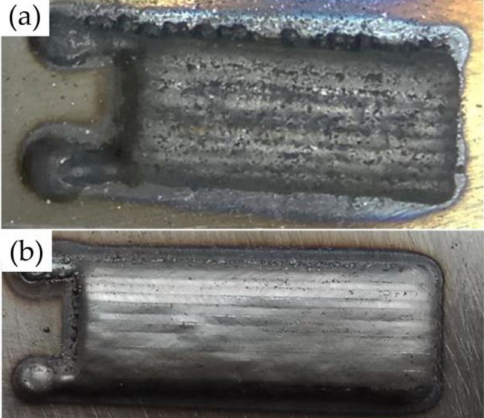
Figure 13. Surface morphology of the LFRed coating on K417G substrate ( a ) before and ( b ) after laser